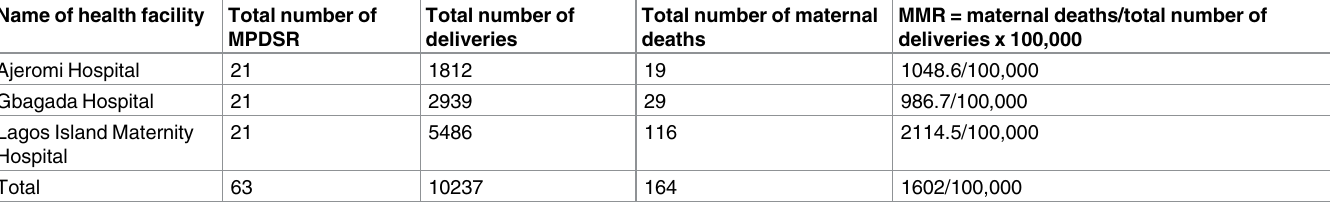
Table 1. Maternal deaths and Maternal Mortality Ratios (MMR) by health facilities.